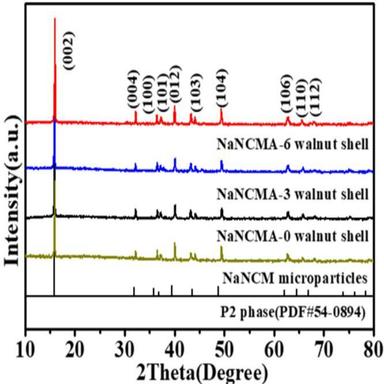
XRD patterns of walnut-shell-like NaNCMA-0, NaNCMA-3, NaNCMA-6 samples and NaNCM micro particles.